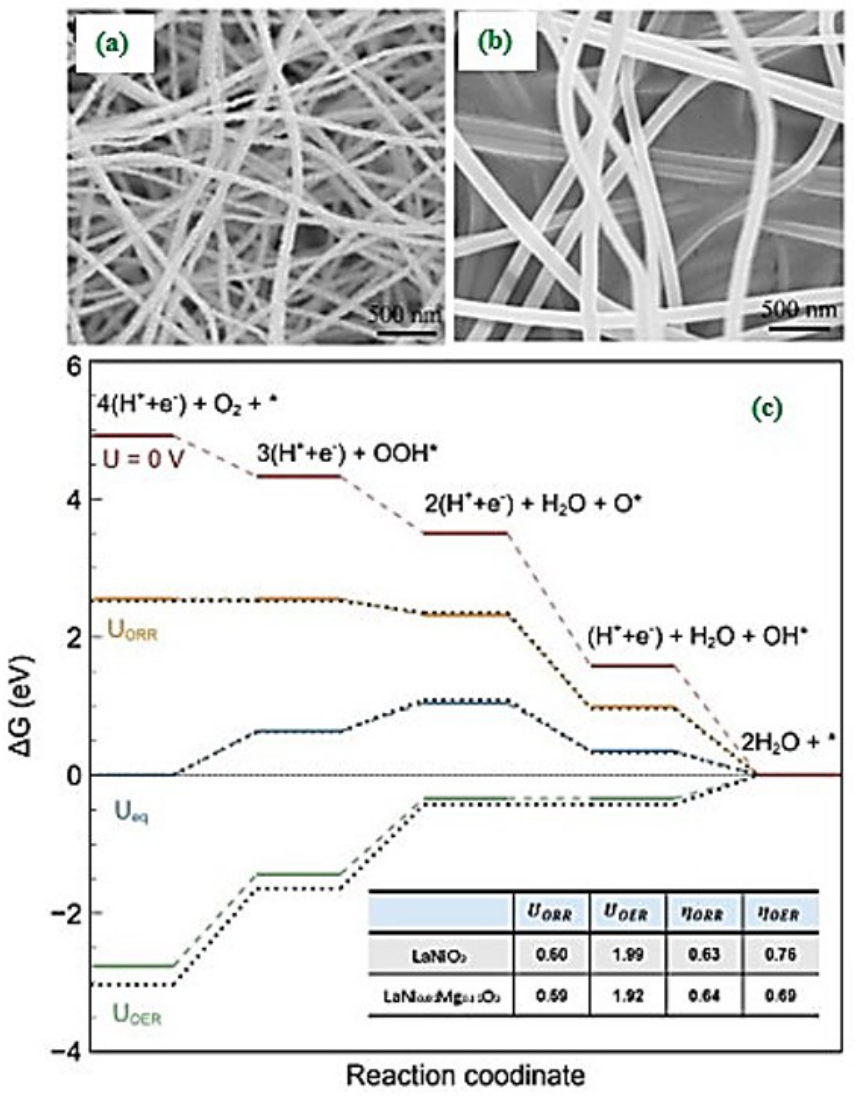
Figure 2. ( a ) SEM image of the as-electrospun product of LNMO ( b ) SEM image of the LNMO NFs after calcination at 700 °C ( c ) Computed reaction free energy diagram for ORR/OER reactions on LNMO 001 surfaces. Copyright 2019 by the American Chemical Society [33].